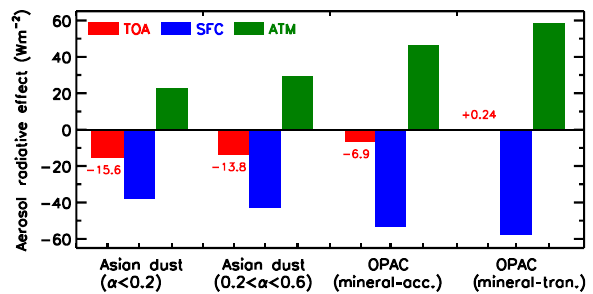
Figure 9. Aerosol shortwave direct radiative effects at the top of the atmosphere (TOA, red color), at the surface (SFC, blue color), and in the atmospheric layer (ATM, green color) for Asian Pure Dust ( α <0.2) and Transported Anthropogenic Dust (0.2< α <0.6) computed in this study. Corresponding values for OPAC mineral- accumulated (mineral-acc.) and mineral-transported (mineral-tran.) modes are also presented for